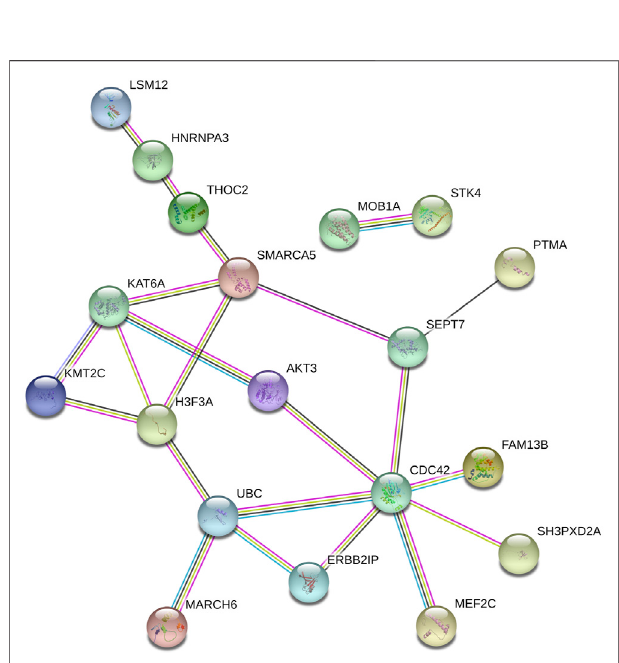
FIGURE 3 | Protein – protein network extracted the mRNA in the ceRNA network.